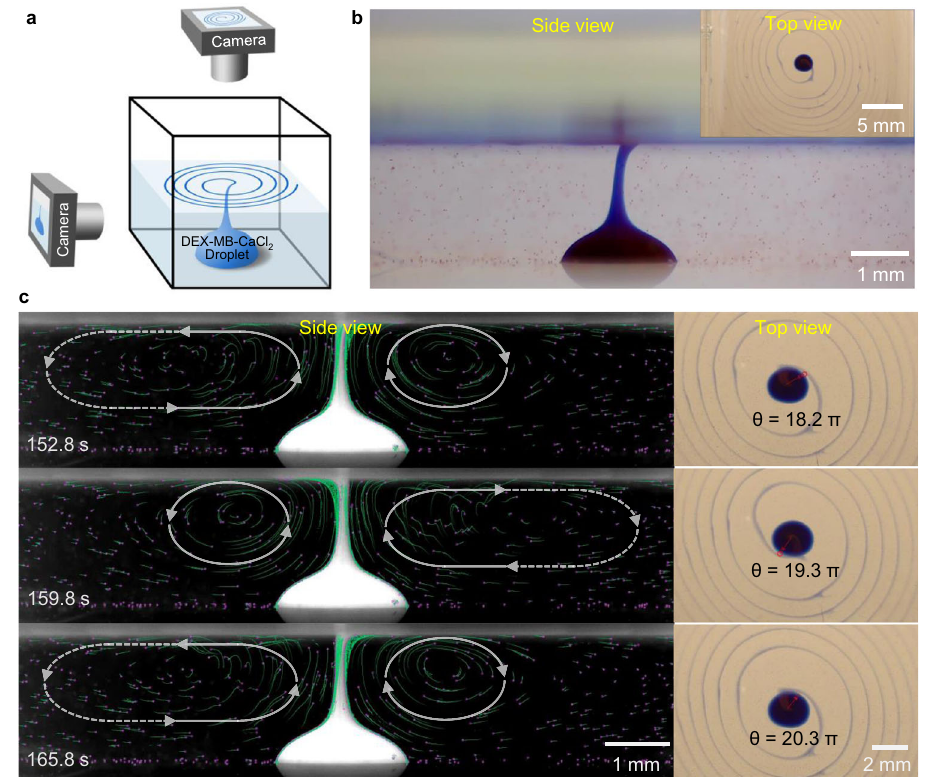
Fig.6|SideviewoftheMarangonitransportprocess.a Schematic of apparatus used to capture the Marangoni convection and the spiral patterns formed by the deposition of a DEX-MB-CaCl 2 (50mM) droplet in a glass cuvette (24×24×24mm) fi lled with PEG-SDBS (2.5 mM) solution (depth 2.5 mm). Cameras were fi xed in the side and top directions to take movies beginning when the droplet was added to the bulk solution. b Coiling (side view) and spiral pattern formation (top view) subsequent to the deposition of the DEX-